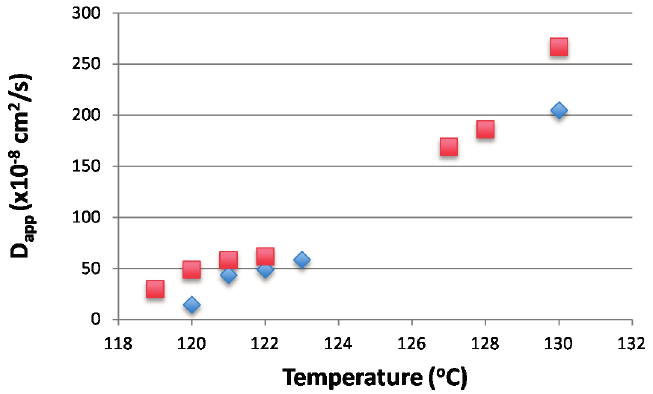
Figure 5. The diffusion coefficients at measured temperatures (20/80 Blend Square, 25/75 Blend in Diamonds).